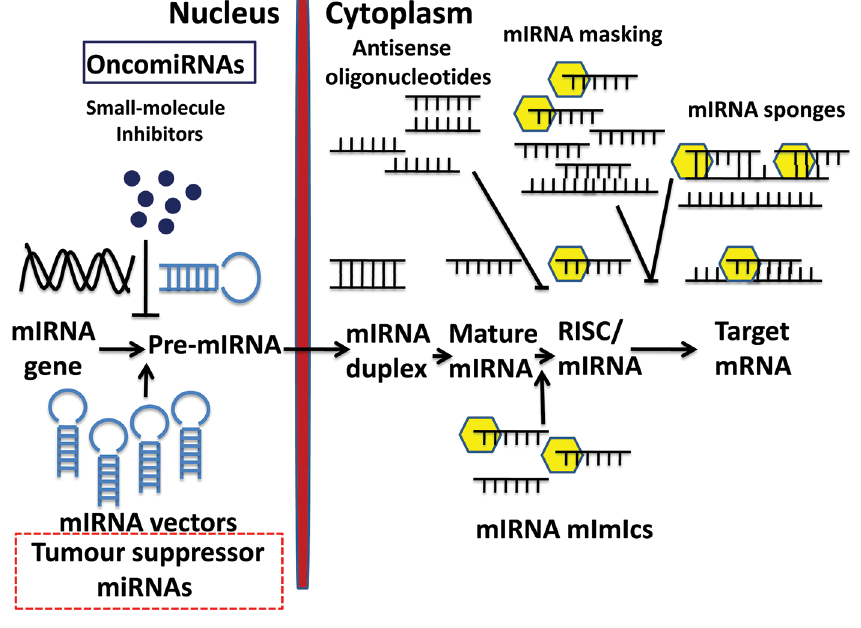
Figure 4. The implication and function of oligos or virus-based constructs can either hinder onco-miRNA expression or induce loss of expression of tumor-suppressor miRNA. A novel approach is using drug to alter miRNA expression by modulating their transcription and processing. Figure reproduced with permission of Elsevier. Fassan M, Baffa R. (2013) MicroRNAs and targeted therapy: small molecules of unlimited potentials. Curr. Opin. Genet. & Dev. 23:75–7. (cited as reference [65] in the current